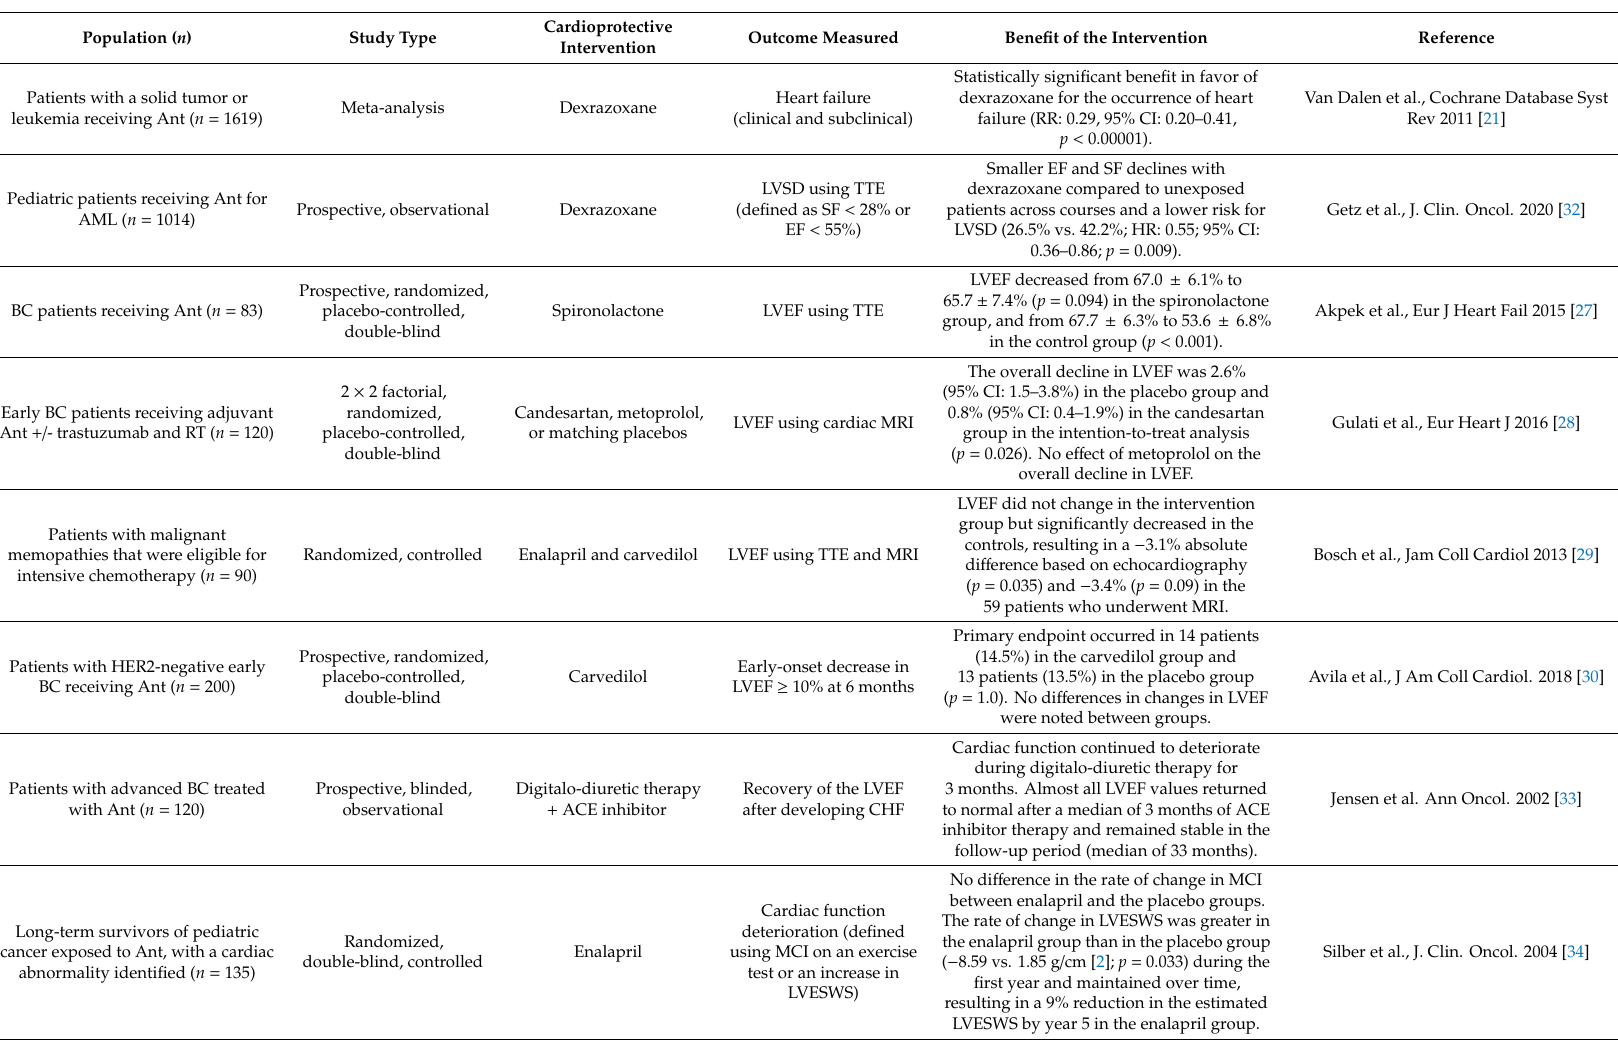
Table 1. Synoptic table of the principal studies on cardiotoxicity: prevention and management of cardiac toxicity occurring during cancer